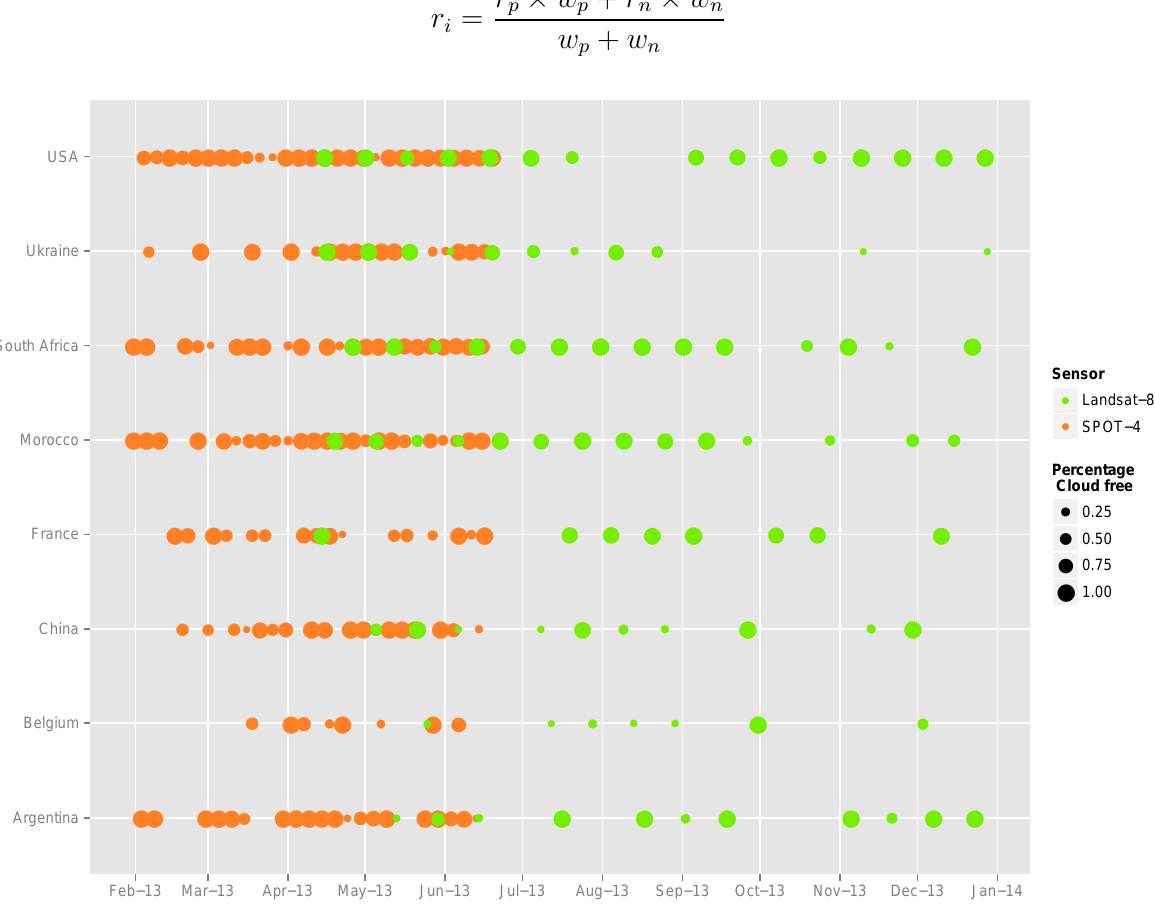
Figure 2. Data availability for the eight sites and cloud-free